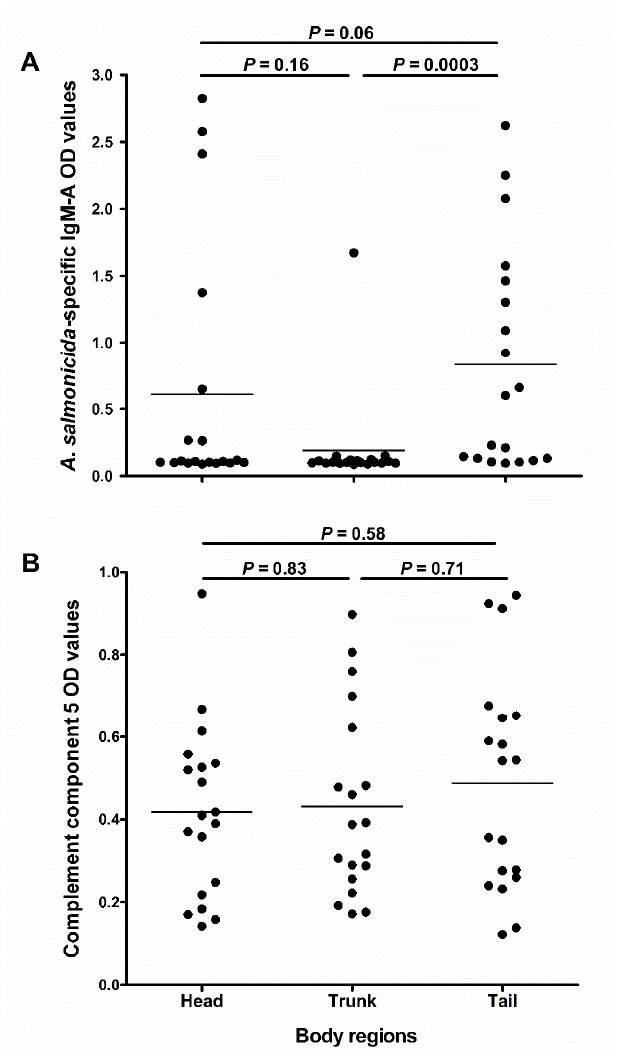
Figure 6. Abundance of immune molecules in mucus from different skin regions of salmon. The dot plots compare ( A ) the A. salmonicida -specific IgM-A OD values (measured using ECAS-CIA) and ( B ) complement component 5 OD values (measured using ELISA) in absorbed skin mucus samples (D1; n = 19) obtained from the head, trunk and tail regions of fish. Horizontal lines represent the median OD values in the di ff erent groups of samples. The nonparametric multiple comparison test (Wilcoxon each pair) was used to calculate the p